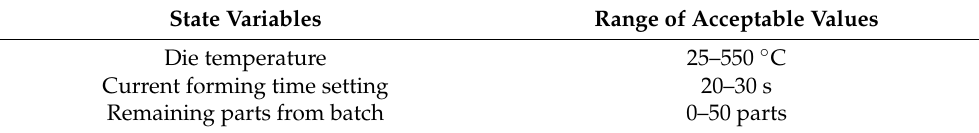
Table 2. Description of the MDP state space.